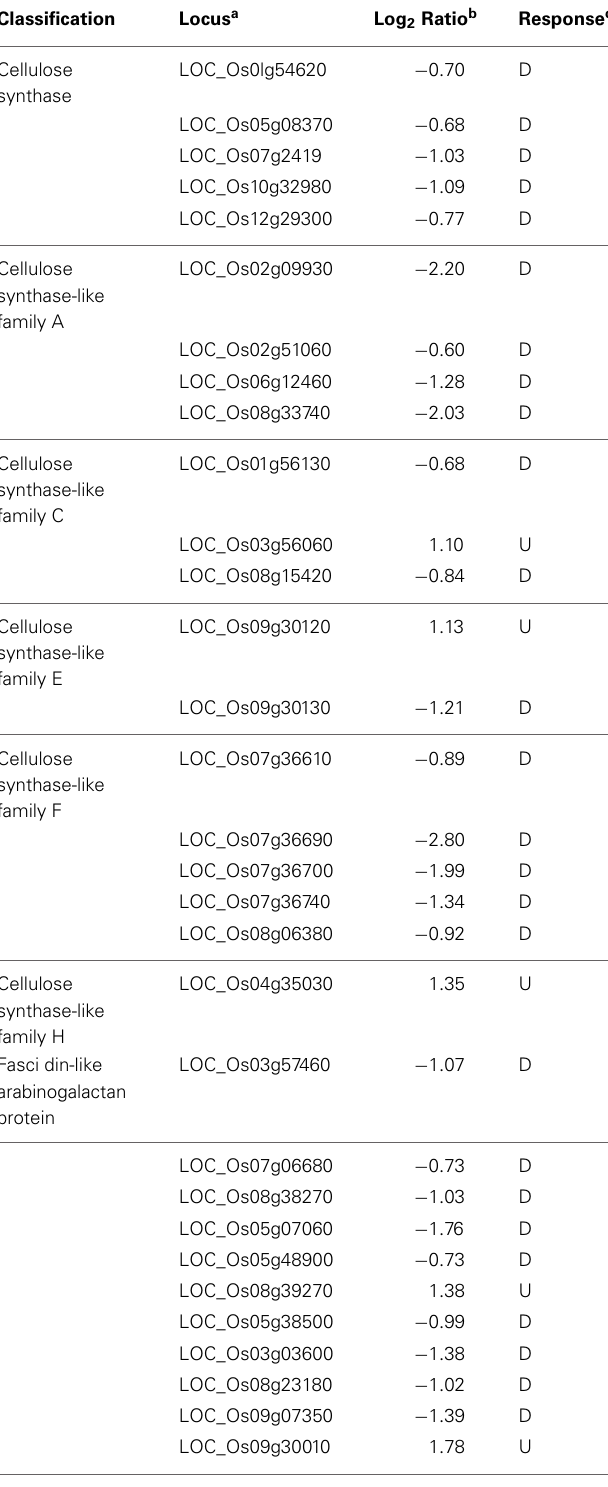
Table 2 | Genes related to cell wall components and tillering in RGSV-infected plants that are up- or down-regulated.